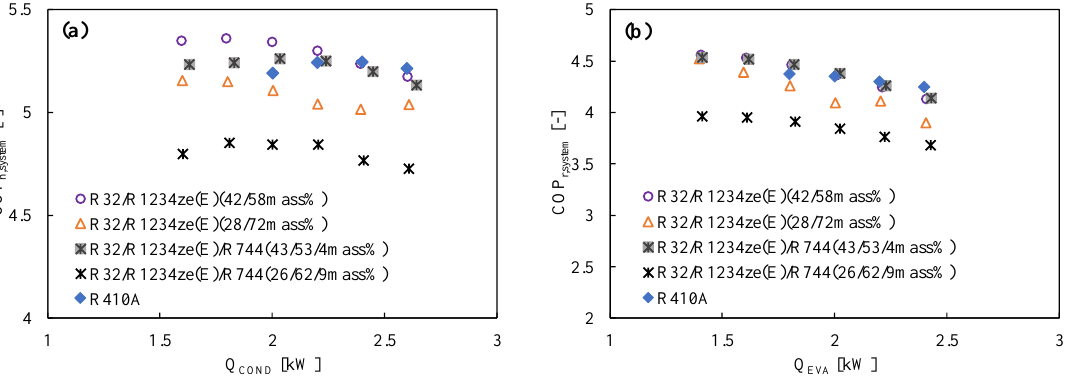
Figure 11. Variation of the COP with the heating and cooling load for R1234ze(E)-based binary and ternary mixtures in a drop-in experiment in ( a ) the heating mode and ( b ) the cooling mode at the optimum charge condition [152].